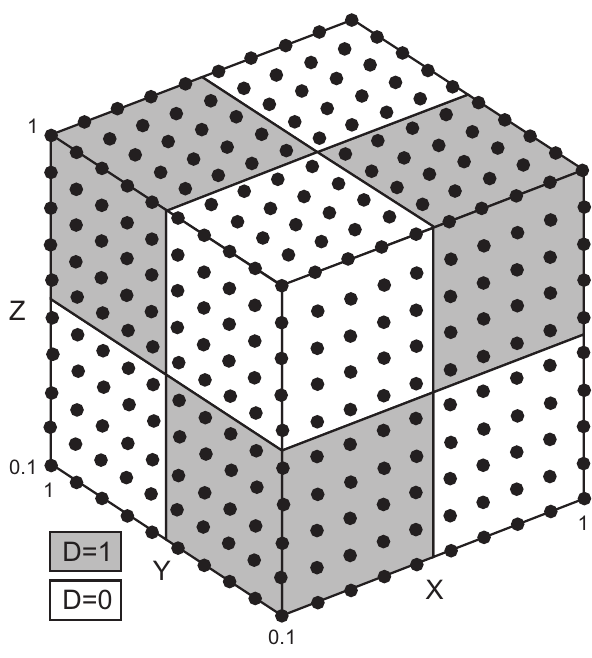
Fig. 2. Theoretical